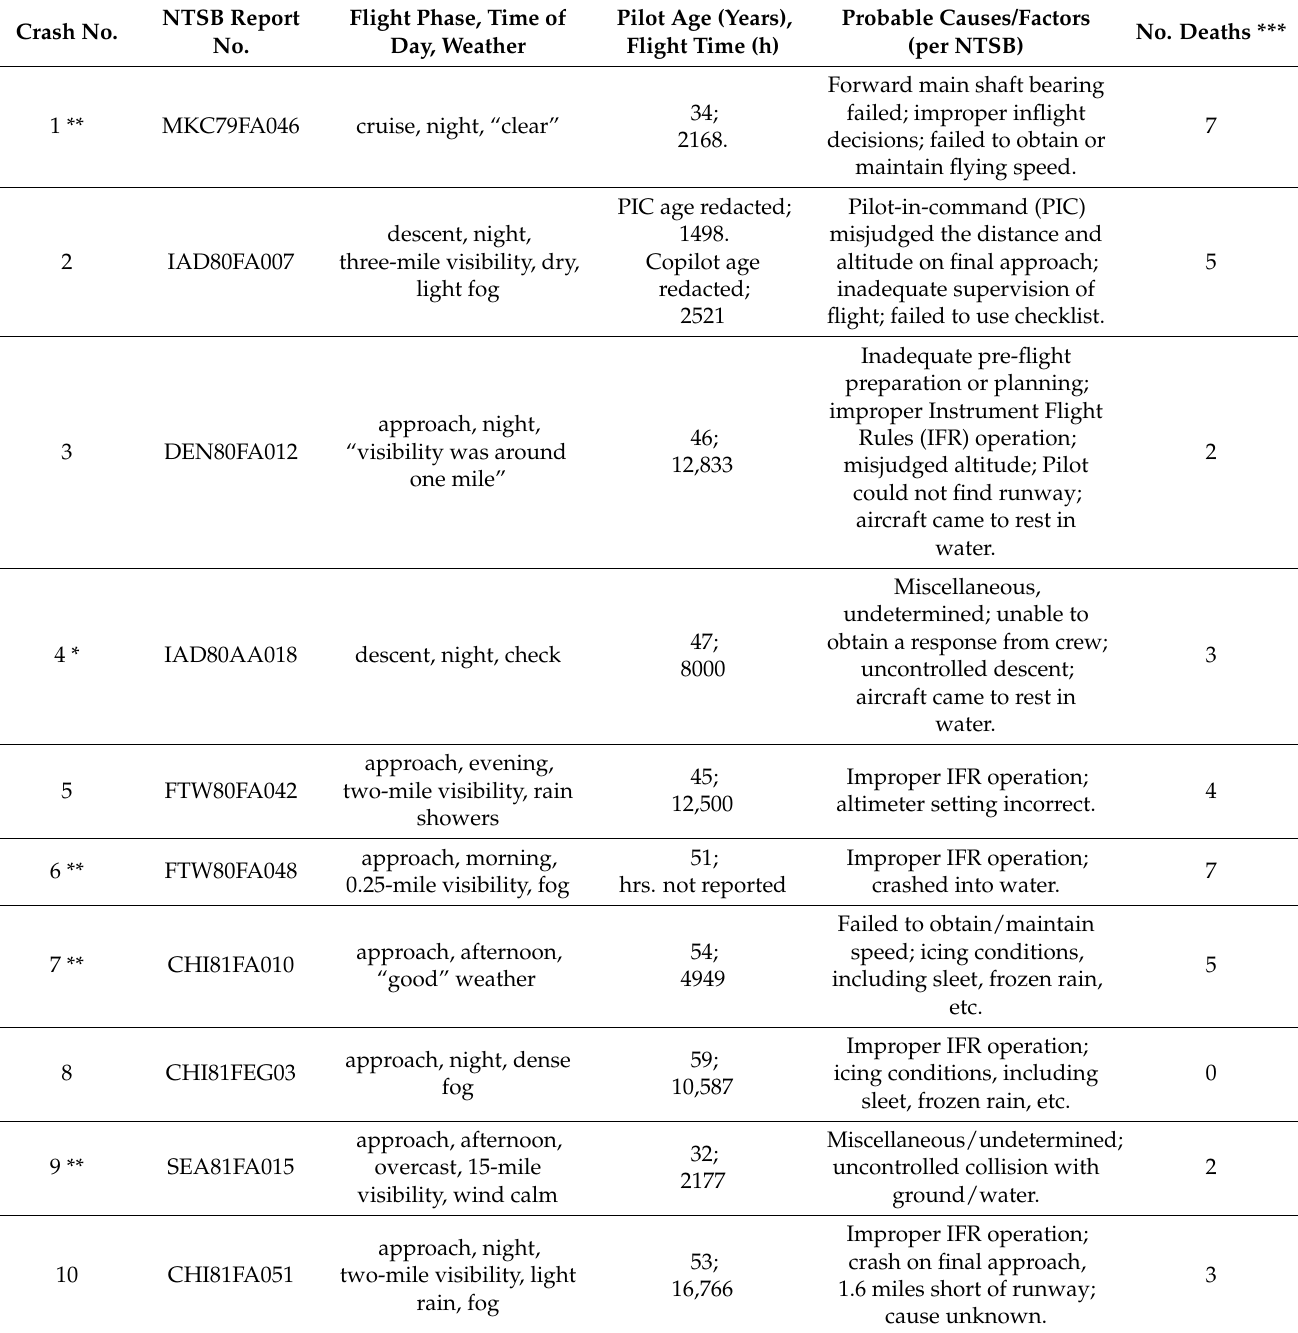
Table 2. Additional details of ten accidents investigated for pilot incapacitation. Crash